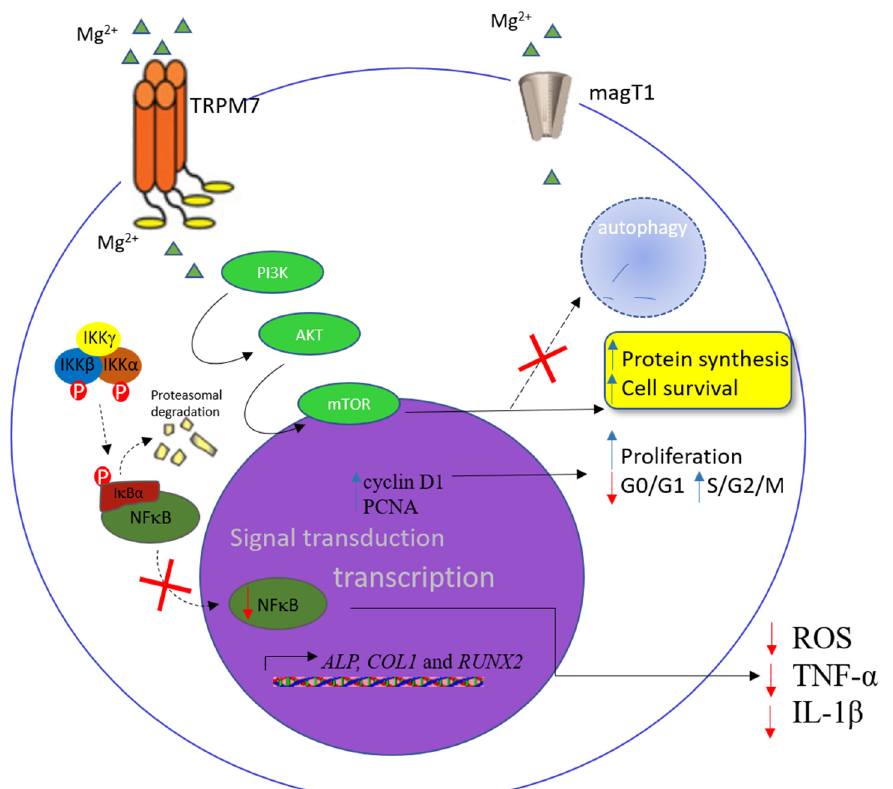
Figure 1. On the hematopoietic cell surface, transient receptor potential cation channel subfamily M member 7 (TRPM7) and magnesium transporter 1(MagT1) facilitate magnesium influx into the cell. In the cytoplasm, the phosphoinositide 3-kinase (PI3K)/protein kinase B (Akt)/mammalian target of rapamycin (mTOR) pathway is magnesium-sensitive, and the activation of this signaling cascade induces cell growth, proliferation, and the inhibition of autophagy. Additionally, increased Mg 2+ concentration is able to decrease proinflammatory cytokine production, by inhibiting the nuclear translocation and phosphorylation of nuclear factor kappa B (NF- κ B) and rise in basal inhibitor of NF- κ B (I ĸ B α ) levels, downregulating tumor necrosis factor alpha (TNF- α ) and interleukin (IL)-1 β release, and reducing ROS production. Solid black arrows indicate the pathway activated, while dot black arrows indicate the pathways inhibited. Red arrows pointing down indicates reduction, while blue arrows pointing up indicates increase.